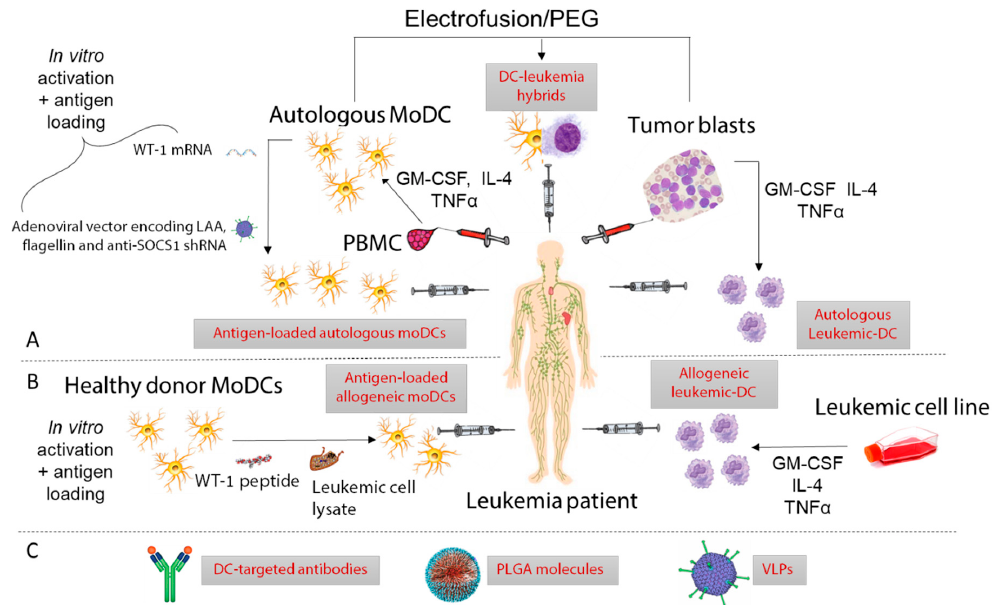
Figure 4. Summary of recent clinical trials and preclinical vaccination strategies utilizing dendritic cells to vaccinate leukemia patients. ( A ) Ex vivo autologous approaches: Autologous moDC